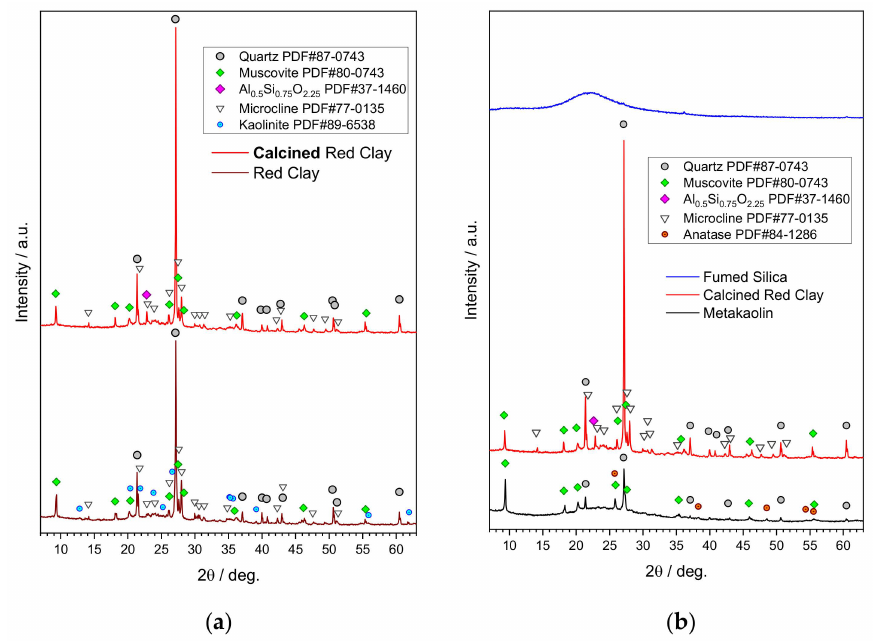
Figure 1. Diffraction analysis of the starting raw materials used to synthesize AAM binders: ( a ) comparison between the local red clay before and after calcination; ( b ) comparison between the commercial metakaolin (MK), local common clay calcined at 800 ◦ C (CRC), and fumed silica (SF).